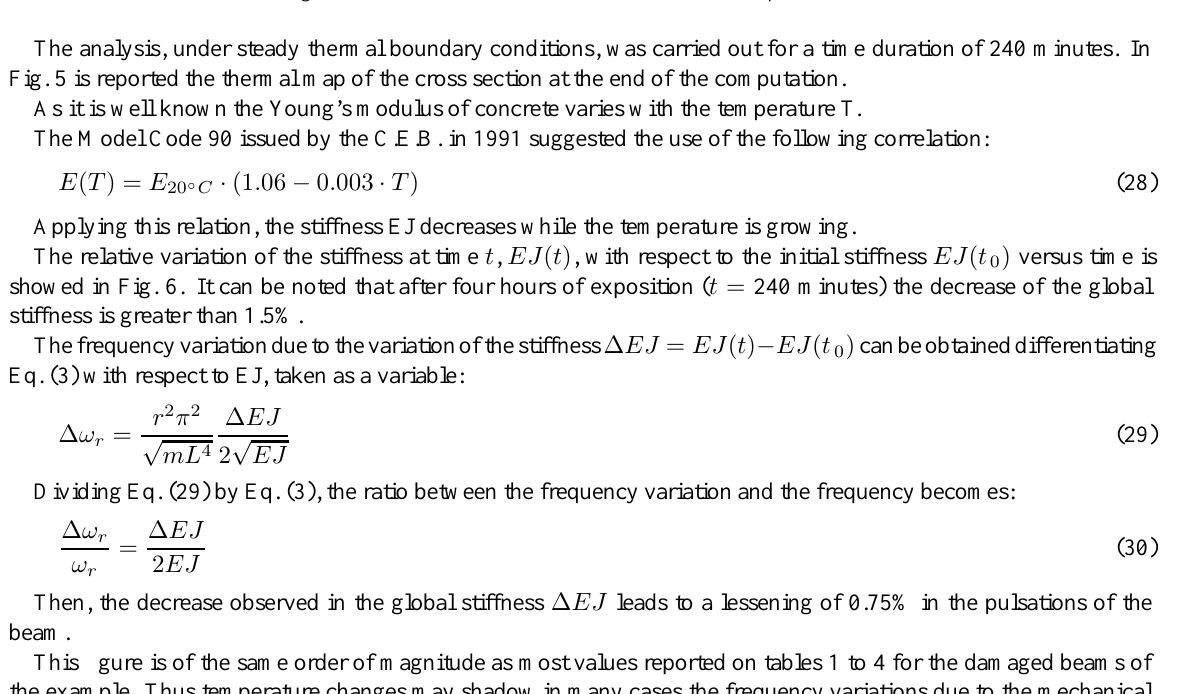
Fig. 6. Relative variation of the stiffness EJ with the time exposure to